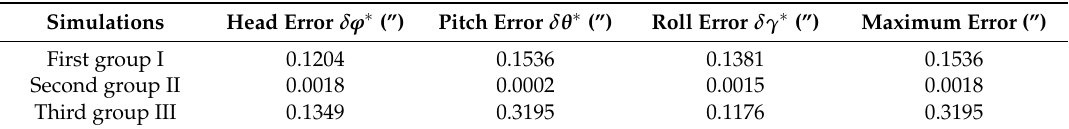
Table 2. Attitude angle errors (RMSE) calculated by the general Euler angle error model.